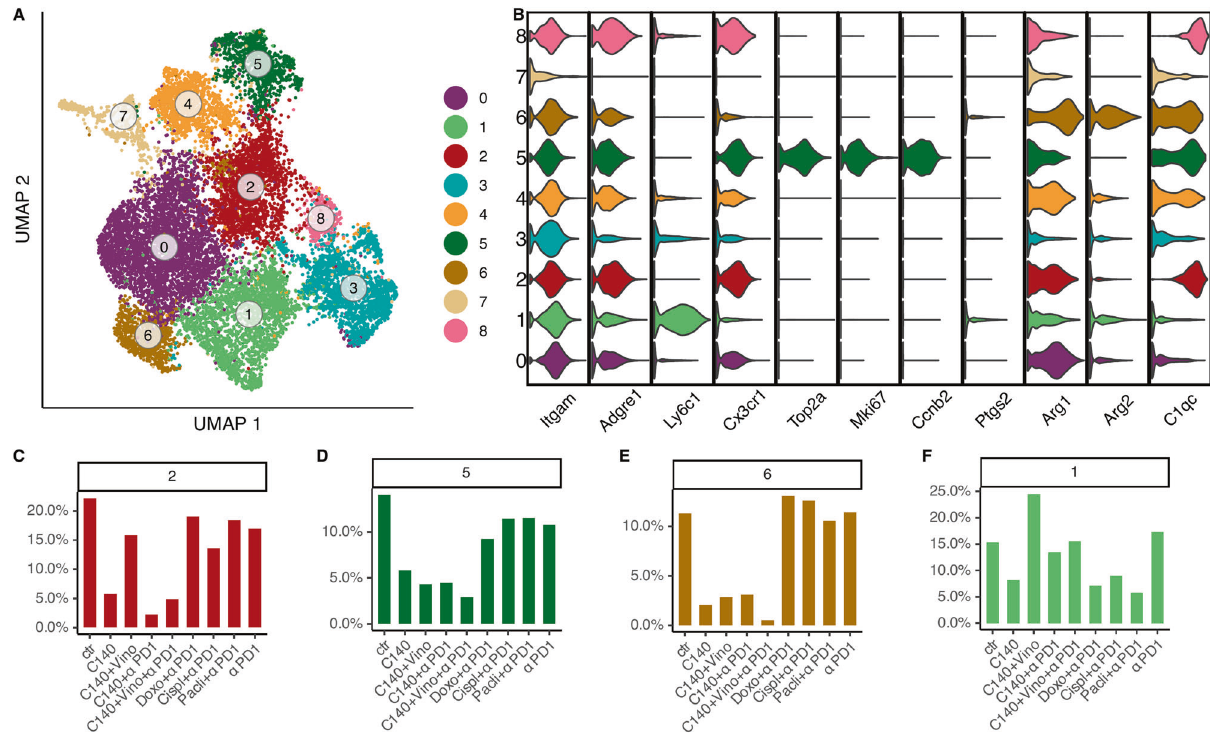
Fig. 4 Macrophage-like cell sub-clustering analysis in EMT6. A UMAP of macrophages sub-clustering in EMT6 cell line. Each dot refers to a cell and the colors refer to the sub-clusters. B Gene signature: the violin plot shows the genes on the x-axis, while the clusters on the y-axis. The colors indicate the corresponding cluster. C – F Proportions of cells in each EMT6 macrophages sub-cluster among different conditions. Bar graph shows on the x-axis the conditions, while the percentage of cells per cluster is plotted on the